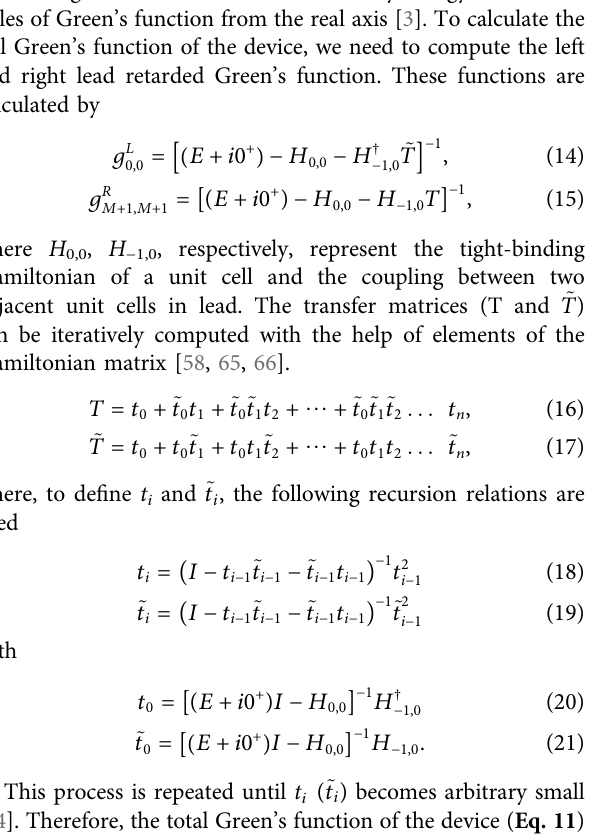
Figure 3 . The Hamiltonian in the con fi ned region can be written as